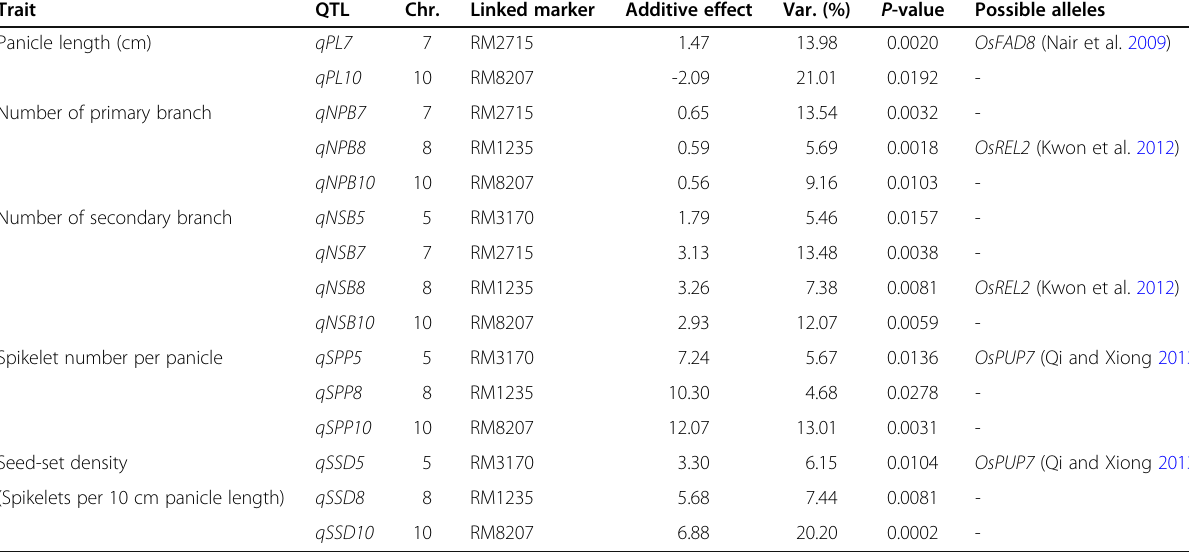
Table 1 QTL for rice seed-set density related traits detected in Z749 Trait QTL Chr. Linked marker Additive effect Var. (%) Panicle length